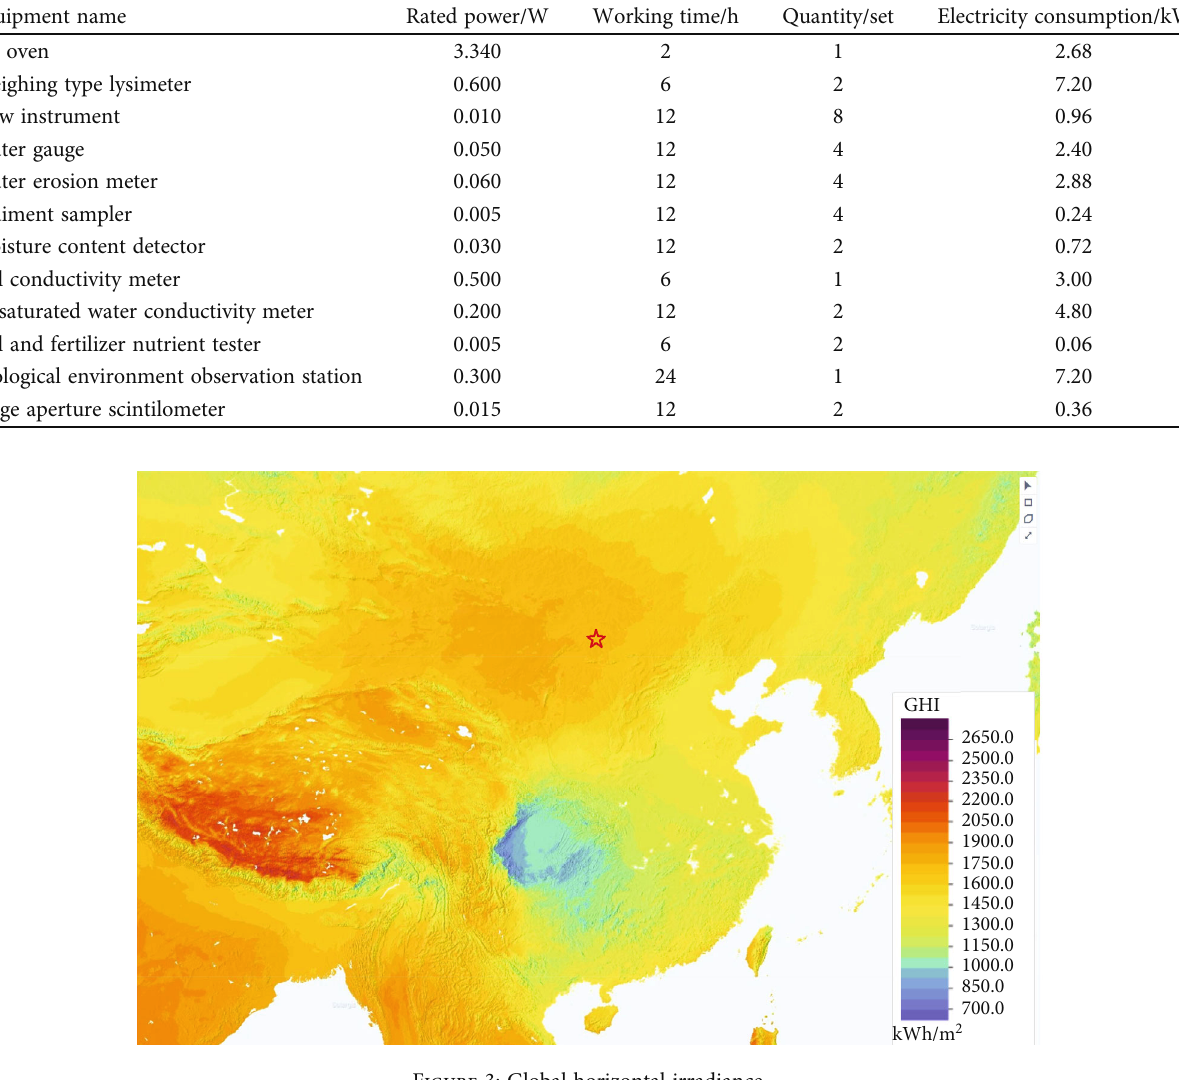
Table 2: Summary table of a load of laboratory